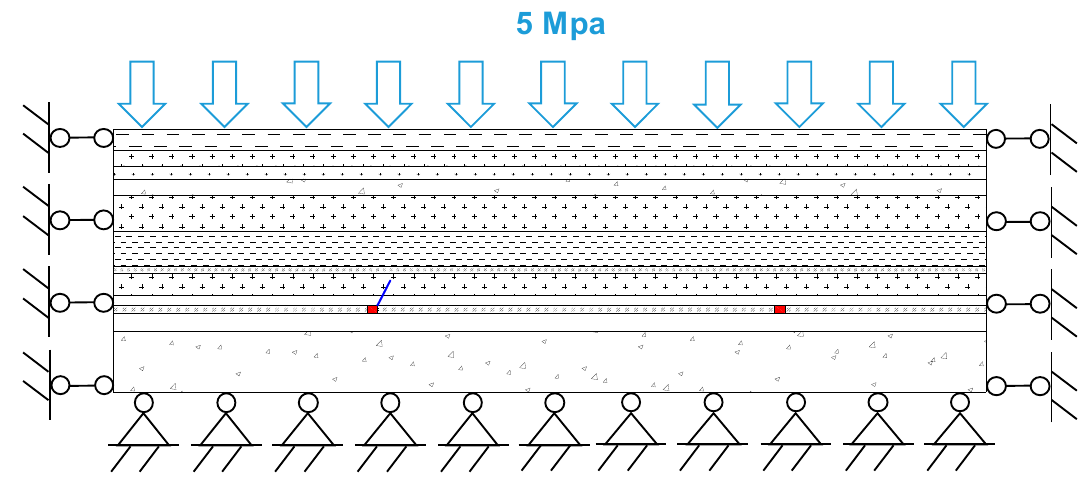
Figure 8. Boundary conditions of the model.